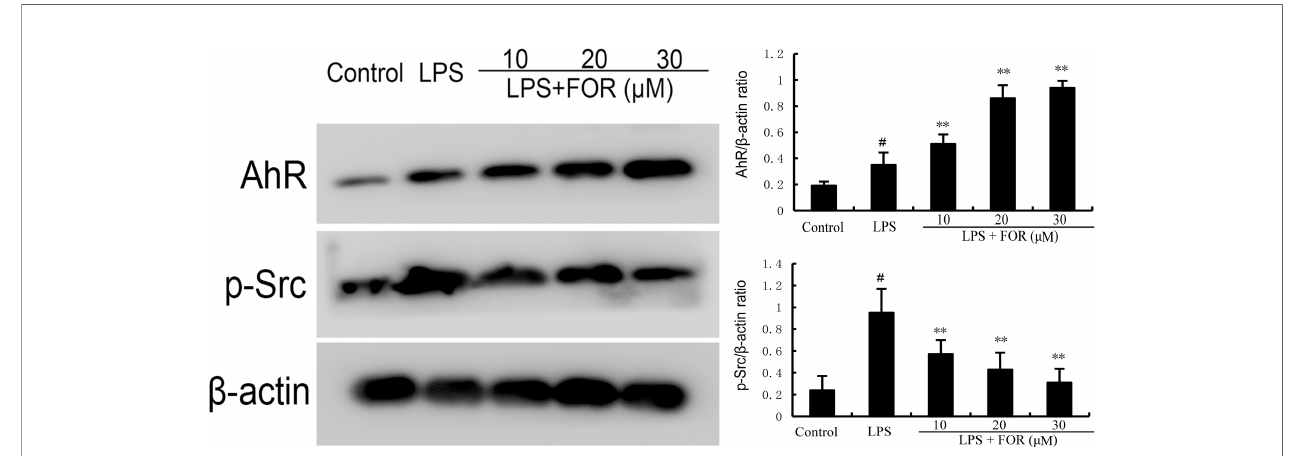
FIGURE 8 | FOR increases AhR expression and inhibits the phosphorylation level of Src. The present results are displayed as the mean ± SEM of triple parallel measurements. # ( P < 0.01) is signi fi cantly different from control group; **( P < 0.01) is signi fi cantly different from